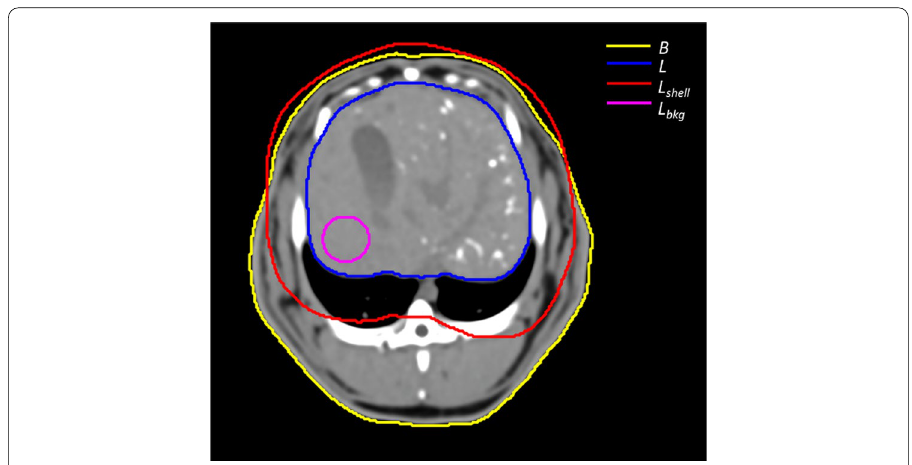
Fig. 2 Baseline unenhanced axial CT slice [ 100 to 200 HU] of R03 following the administration of Eye90 − showing four structures: the rabbit’s body B (yellow), the liver volume L (blue), the liver extended by an isotropic 1 cm margin L shell (red), and the non-embolized, homogeneous background region L bkg